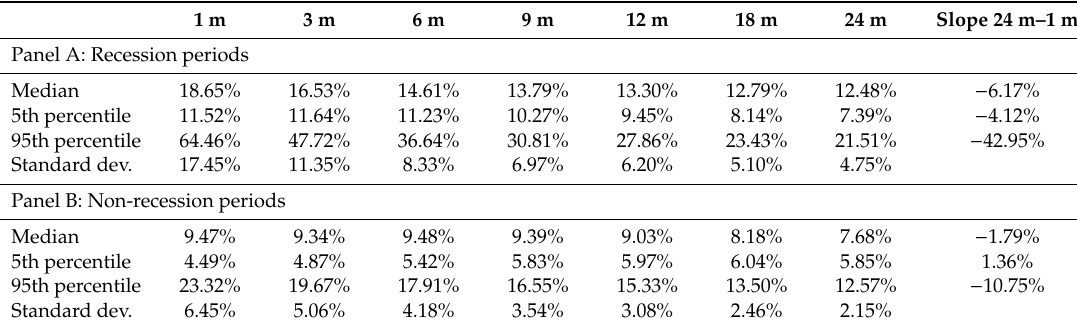
Table 1. Summary